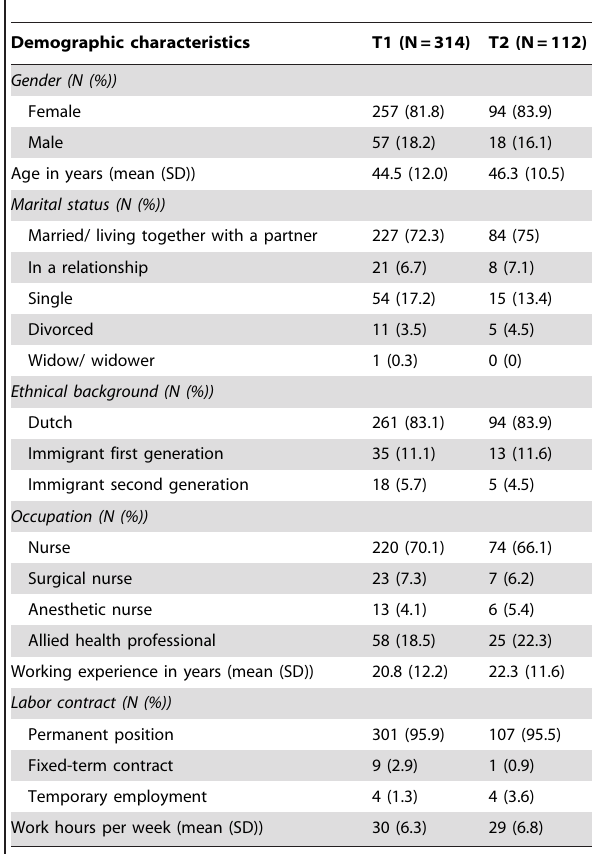
Table 1. Socio-demographic characteristics of the two